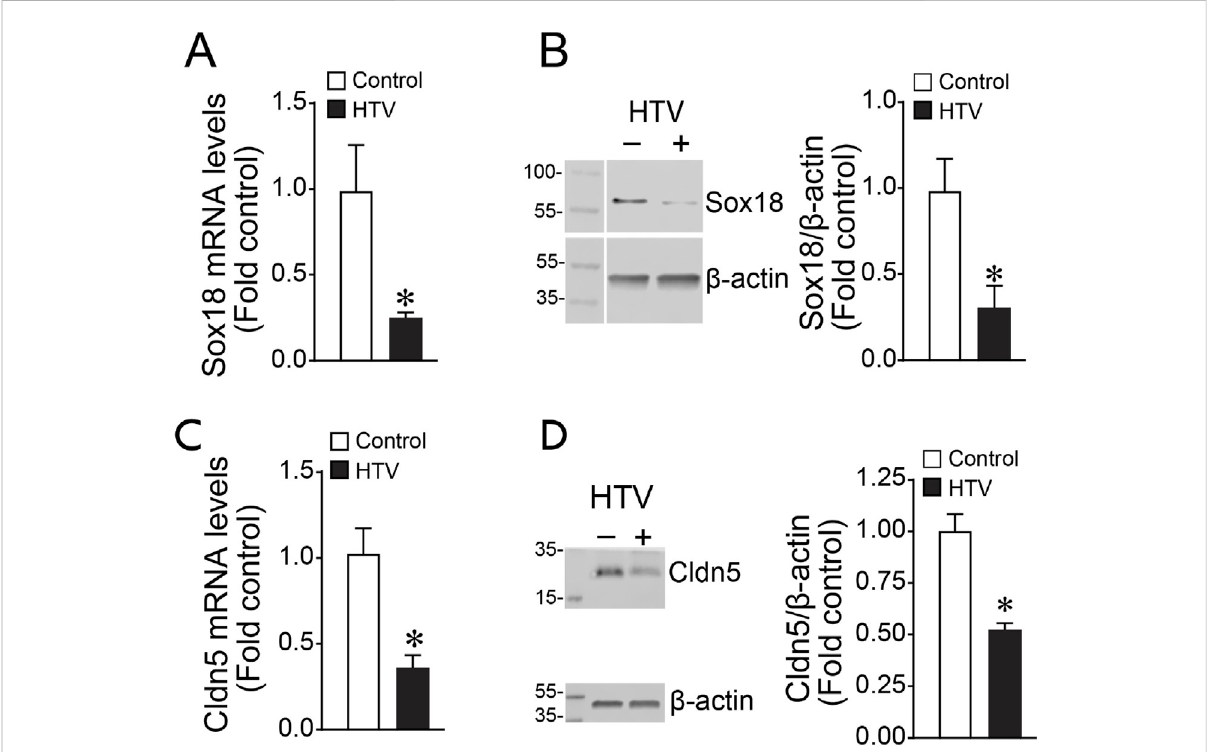
FIGURE 5 Sox18 and Cldn5 expression are reduced in the mouse lungs subjected to high tidal mechanical ventilation. The mice were exposed or not to ventilationwithhigh tidal volume (HTV;30 ml/kg, 75bpm, 0.5 FiO 2 )for 8h. Protein extractspreparedfrom lung tissue homogenates weresubjected to immunoblot analysis using Sox18 and Claudin-5 antibodies. mRNA isolated from mice lung tissues were subjected to cDNA synthesis and SYBR green qRT-PCR using speci fi c primers directed to Sox18 sequence and normalized to β -2-Microglobulin, a housekeeping gene. qRT-PCR analysis demonstrated a signi fi cant decrease of Sox18 expression (A) , matching the reduced Sox18 protein levels as determined by densitometric analysis (B) . Similarly, Cldn5 mRNA after cyclic stretch is diminished (C) , correlating with a decrease in Cldn5 protein levels as measured by immunoblot and densitometric analysis (D) . * p < 0.05 versus Control. N = 4 – 6 (A) ; N = 3 – 5 (B) ; N = 8 – 12 (C) ; N = 3 – 5 (D)